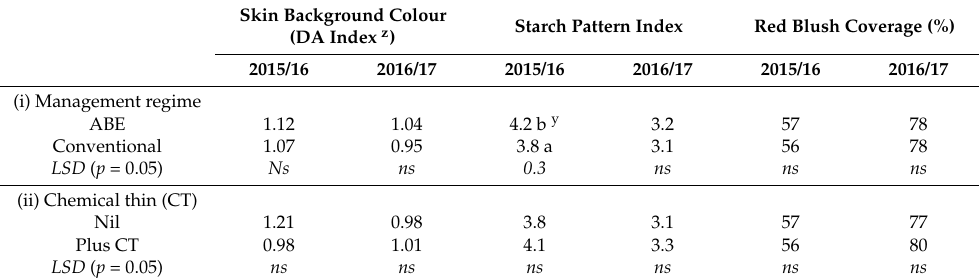
Table 9. Effect of management regime and thinning method on fruit maturity and blush intensity of ‘Fiero Fuji’ (Trial 3). ABE = artificial bud